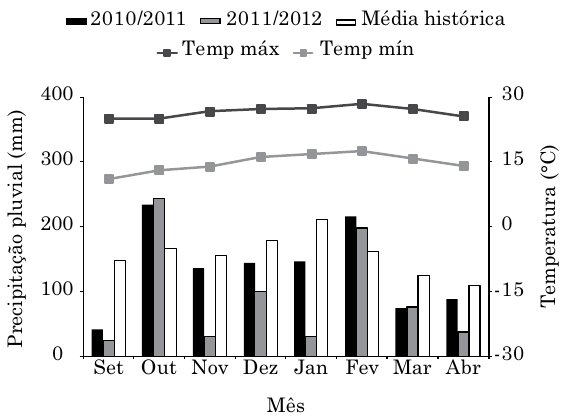
figura 1. precipitação pluvial e temperaturas máximas e mínimas, médias mensais, ocorridas durante o período de realização do experimento (setembro de 2010 a abril de 2011 e setembro de 2011 a abril de 2012) e precipitação média mensal histórica (36 anos) da região de tibagi,